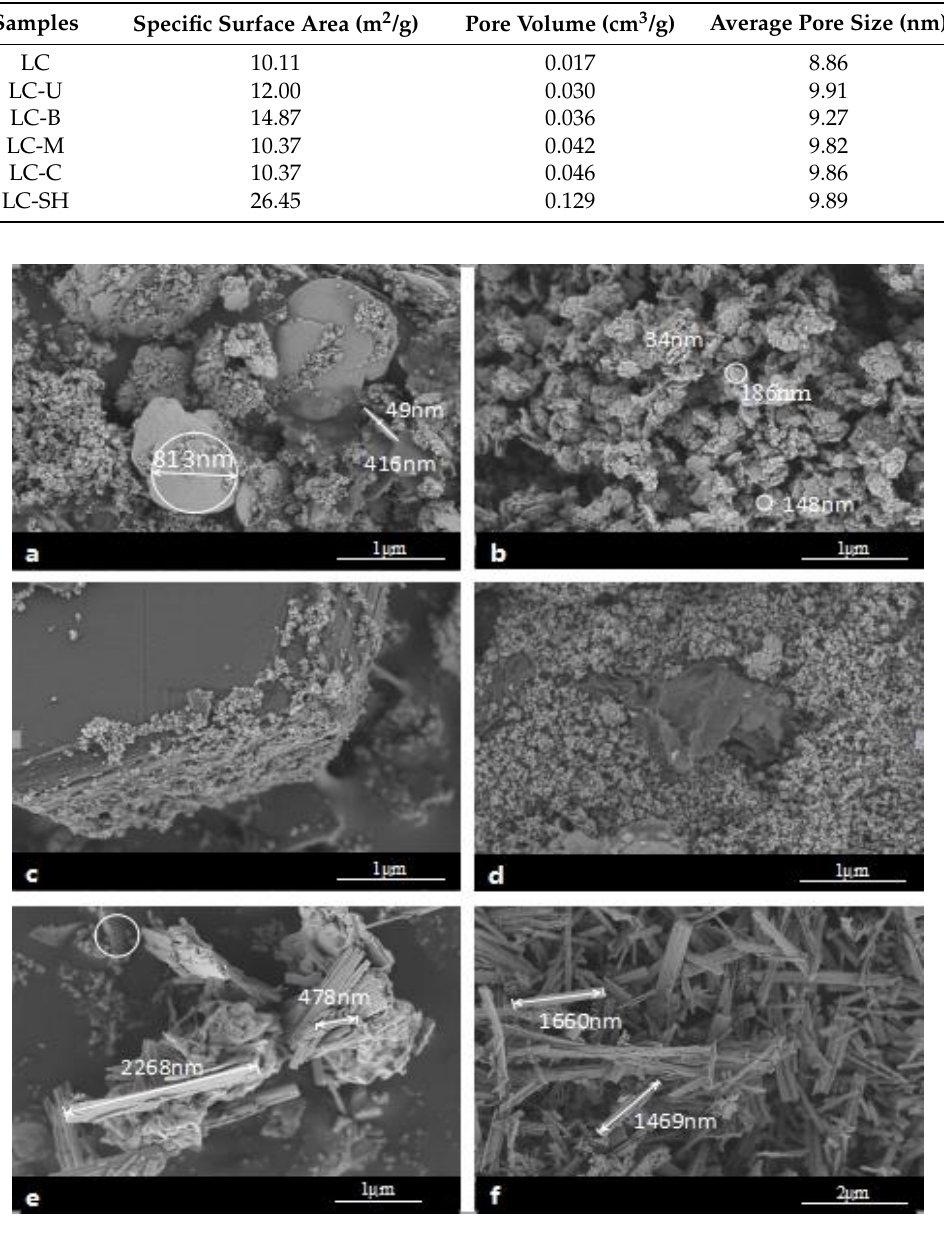
Table 1. Brunauer-Emmett-Teller (BET) results of catalysts with different nitrogen sources.